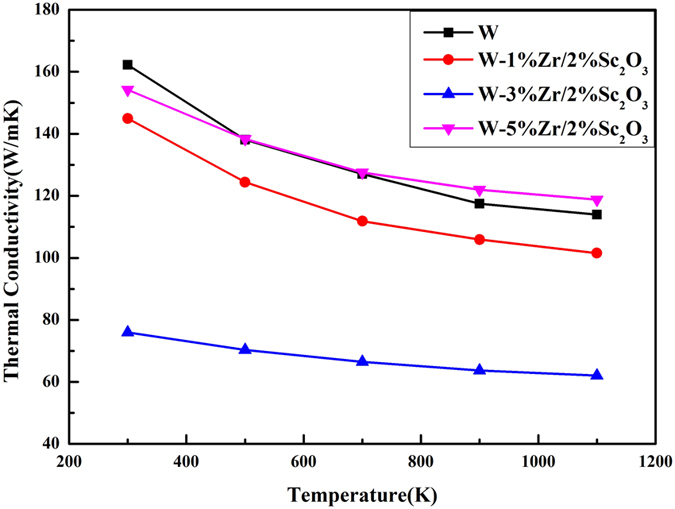
The thermal conductivity of W–Zr/Sc2O3 composites.